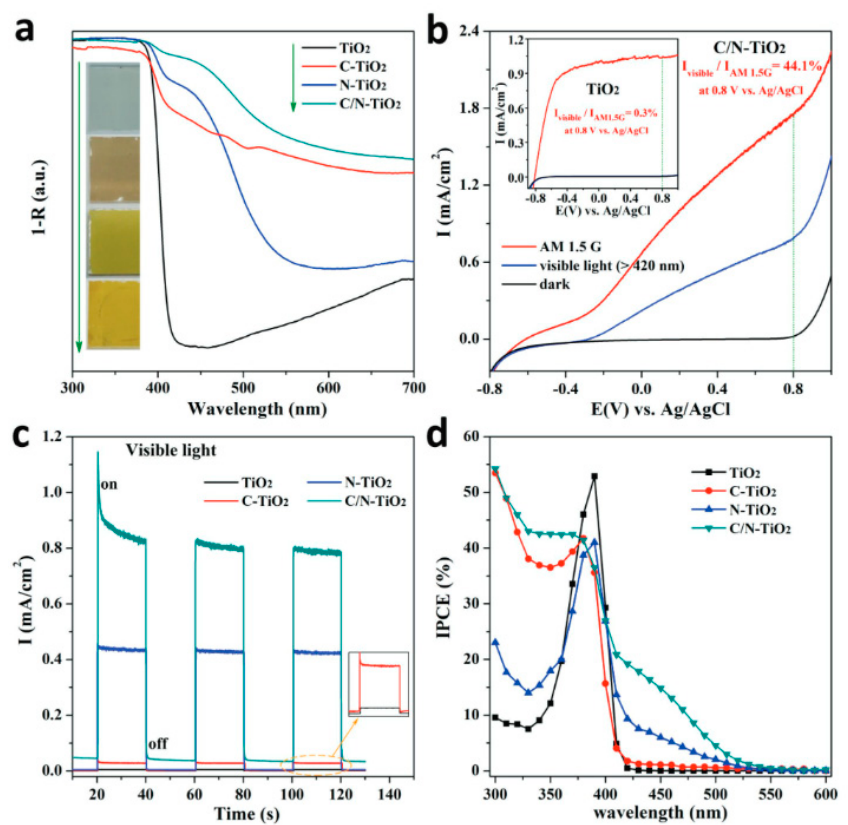
Figure 5. ( a ) UV–vis absorption spectra of TiO 2 and various doped TiO 2 . ( b ) Linear sweep voltammograms of C/N-TiO 2 and TiO 2 . ( c ) Photo-response of TiO 2 and the various doped TiO 2 samples under visible light. ( d ) Incident photon-to-current conversion efficiency spectra of TiO 2 and various doped TiO 2 . Adapted with permission from Reference [48]. Copyright (2018) Wiley.